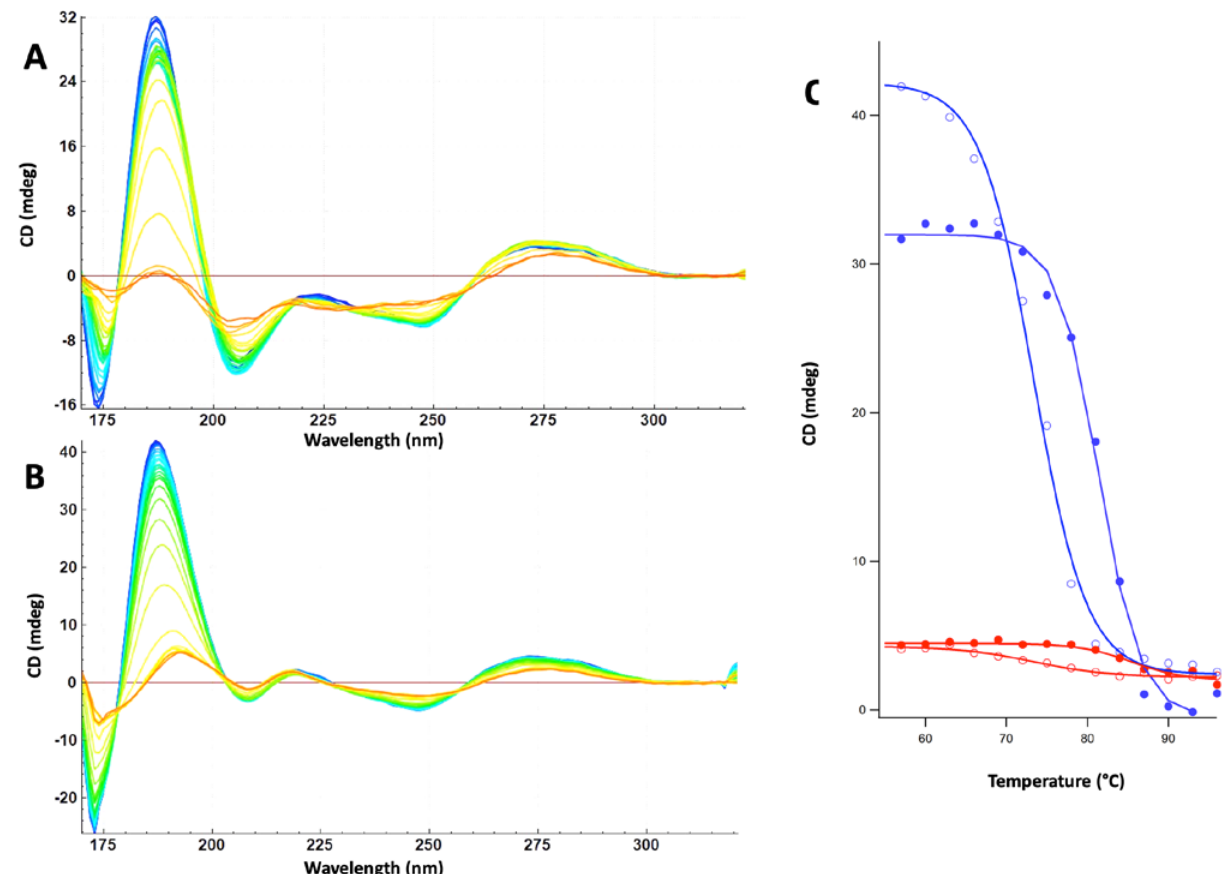
Figure 11. ColE1 C-stretch temperature melting using SRCD (from blue 15 °C to red 95 °C). ( A ) Melting with the CTR. ( B ) Melting without the CTR. At 15 °C, ColE1 C-stretch forms a B helix: the correlation between spectra at 15 °C and spectra of the B-form helix was investigated using Pearson correlation tests. We found a correlation of 0.9052 for a p -value of 1.29063 × 10 −5 7 for colE1 C-stretch and a correlation of 0.95848 for a p -value of 1.23619 × 10 −83 for colE1 C-stretch in the presence of the CTR. ( C ) The corresponding T m were 81.4 ± 0.3 °C, 73.4 ± 0.3 °C, 85.4 + 5±1 °C and 73.4 ± 1 °C at 188 (blue) and 275 (red) nm with (full circle) and without the CTR (empty circle), respectively.